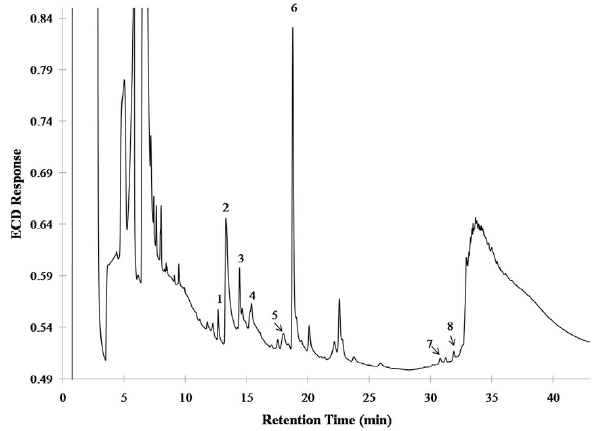
Figure 6. GC-ECD chromatogram of an isoprene/NO x yield experiment. The numbers correspond to the INs produced in the yield experiment. Fig. 6. GC-ECD chromatogram of an isoprene/NO x yield exper- iment. The numbers correspond to the INs produced in the yield experiment.